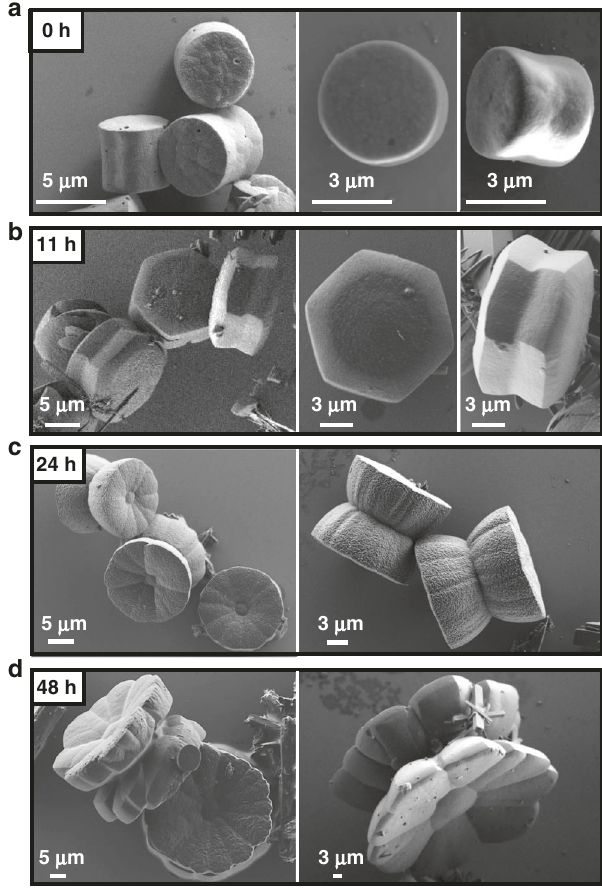
Fig. 6 Evolution of the yo-yo-like single crystals as function of the aging time. Scanning electron microscopy (SEM) images. a after the solvothermal reaction (0 h), and after b 11 h, c 1 day and d 2 days of room temperature aging.